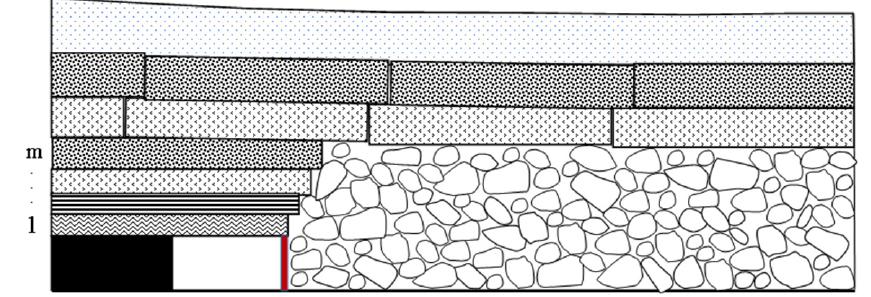
Figure 5. Fracture form of roof.